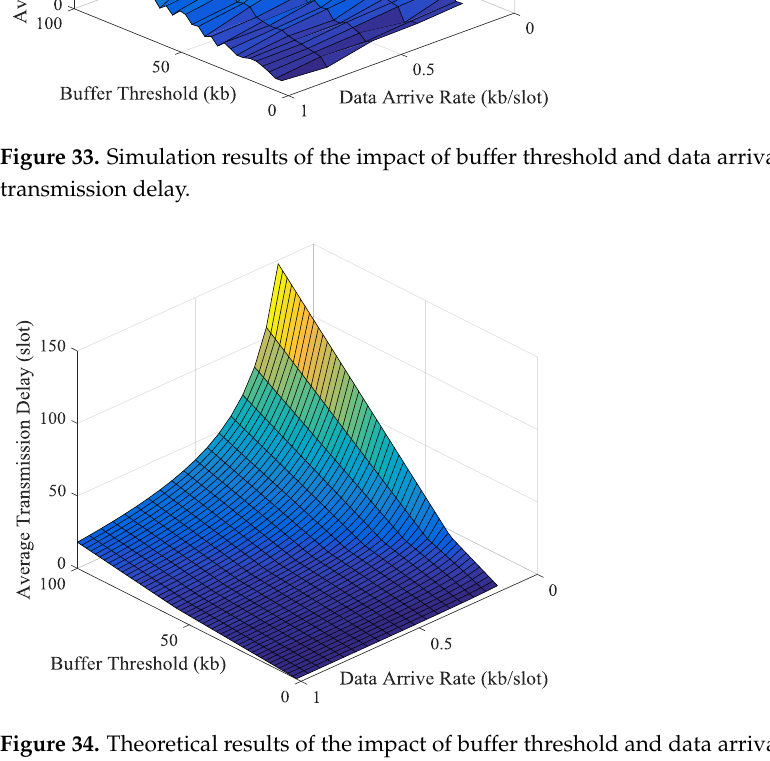
Figure 34. Theoretical results of the impact of buffer threshold and data arrival rate on the average transmission